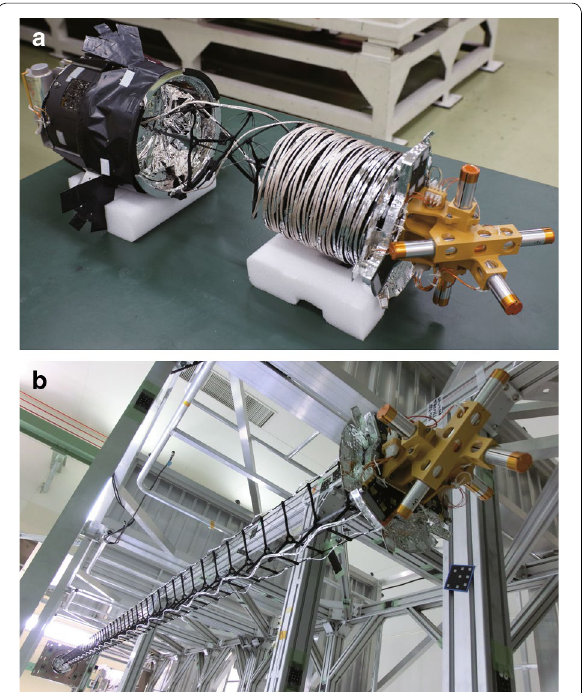
Fig. 5 Photographs of the MSC-S mounted on the top of the MAST in both a stowed and b extended positions. The length of the MAST in full extension is 5.2 m from the side panel of the satellite